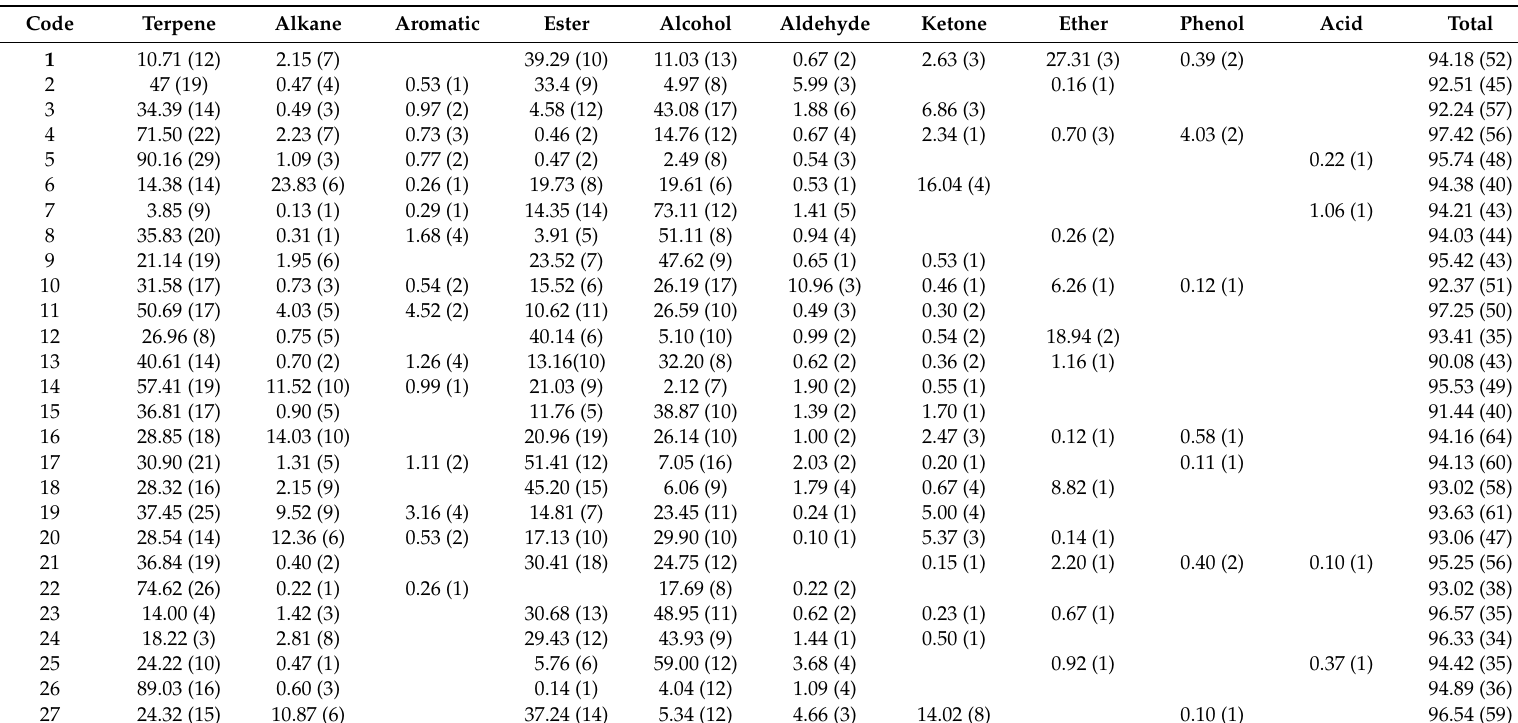
Table 2. Relative contents (%) and number of components for 10 floral scent compound categories emitted from twenty-seven bearded iris